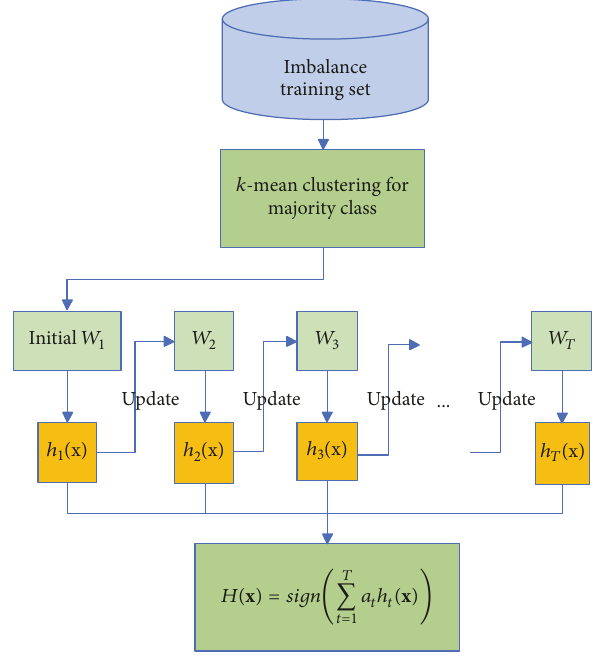
Figure 5: The flowchart of CBoost